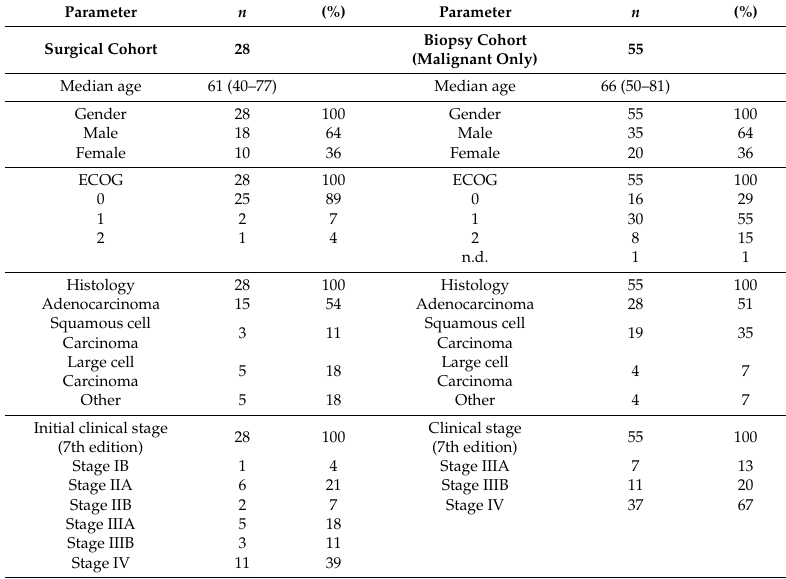
Table 1. Cohort characteristics.